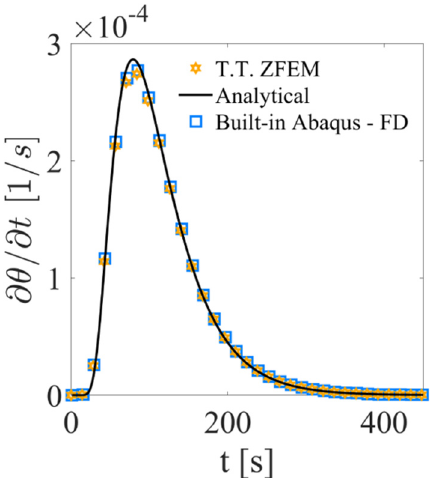
Figure 7. The heating rate in time for fin tip: solid black line, rate using analytical differentiation in Equation (23), yellow star, rate using Transient Thermal ZFEM, blue square, FD using Abaqus built-in element solution.